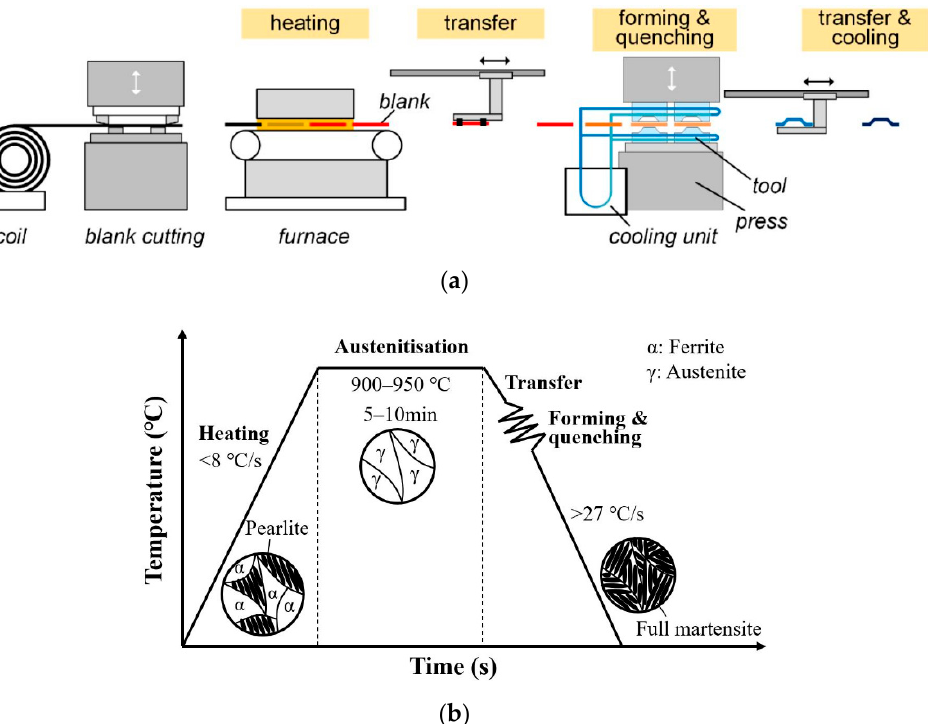
Figure 1. Illustration of conventional hot stamping process for Mn-B steel: ( a ) Basic hot stamping process chain [6] (Reproduced with permission of Pentera, 2020). ( b ) Thermomechanical cycle and microstructural evolution during hot stamping.